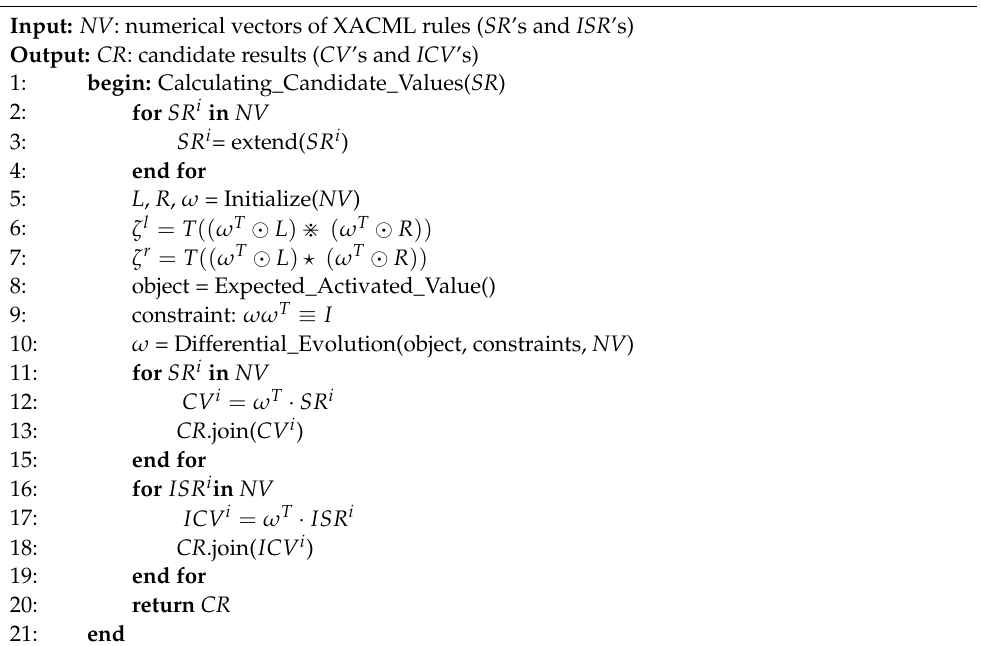
Algorithm 1: Calculating Candidate Results for XACML